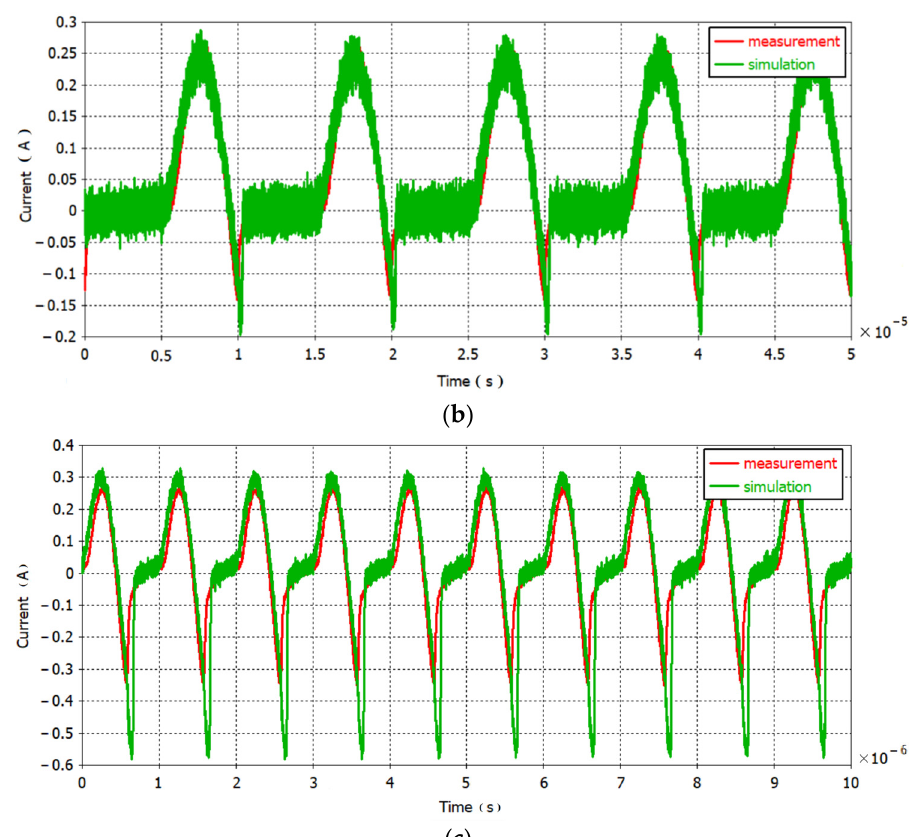
Figure 20. Comparison of measured and simulated in time-domain: ( a ) 10 kHz; ( b ) 100 kHz; ( c ) 1 MHz.